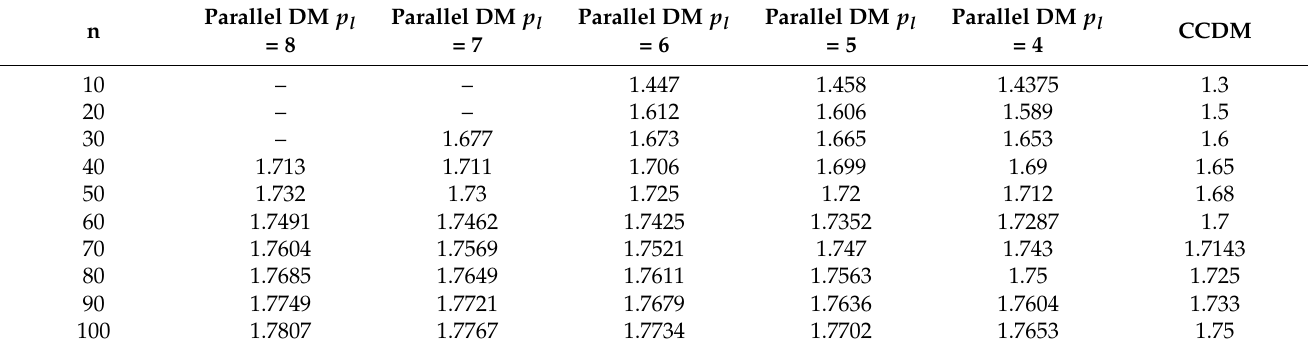
Figure 3. Rate over block length n for CCDM and parallel distribution matcher (Rmax and Rmin); the probability distribution is P A = { 0.4,0.3,0.2,0.1 } . Table 2. Rate of CCDM and parallel DM under different block lengths n